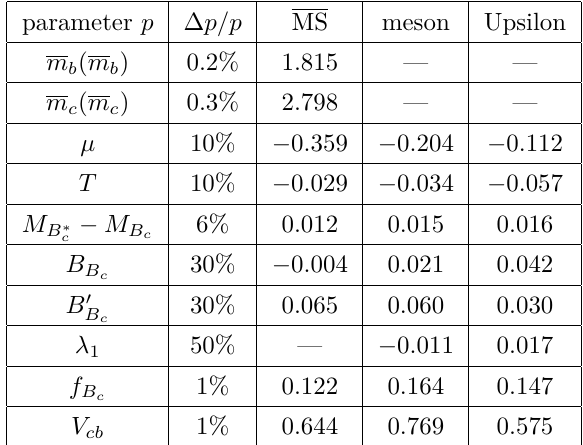
. The three last columns show the quantity ∆Γ Bc c